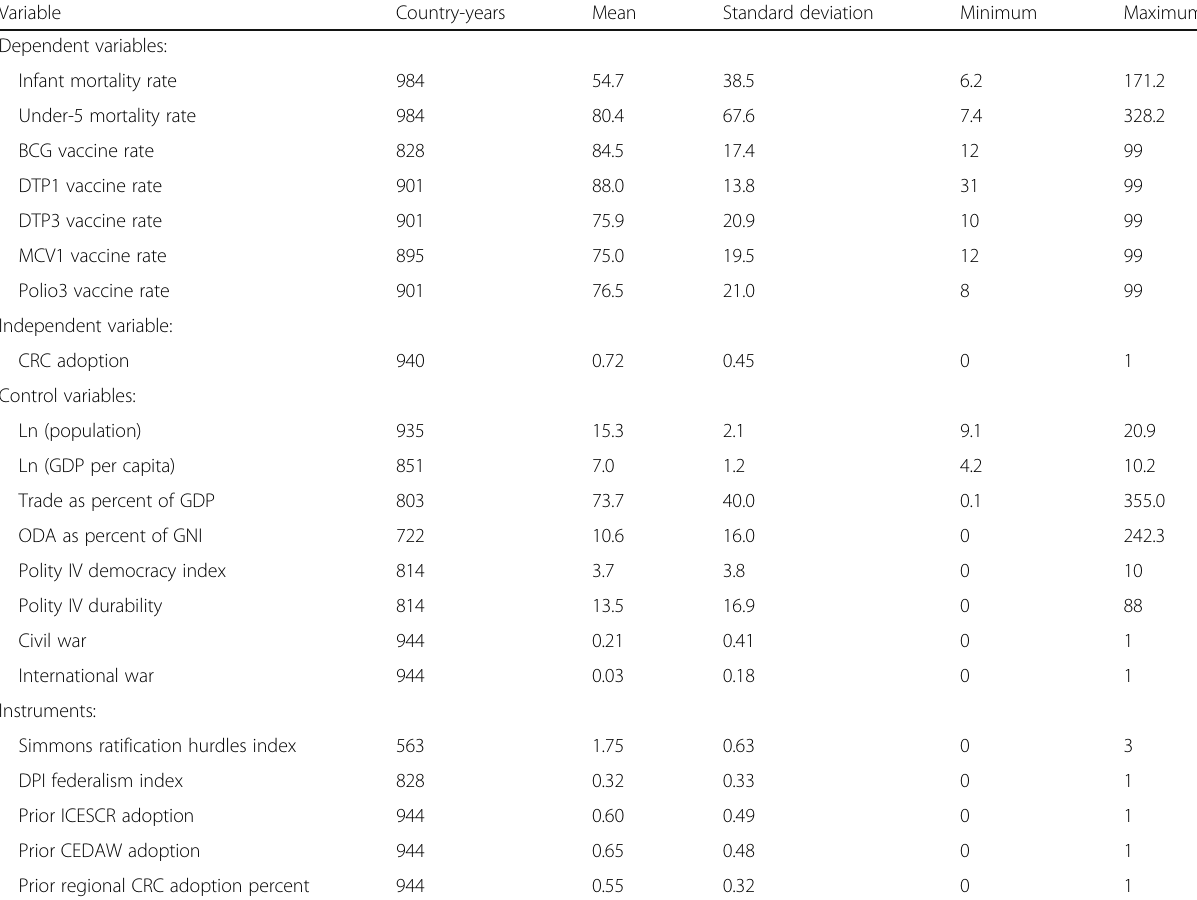
Table 2 Descriptive statistics for study variables from 1990 to 1995